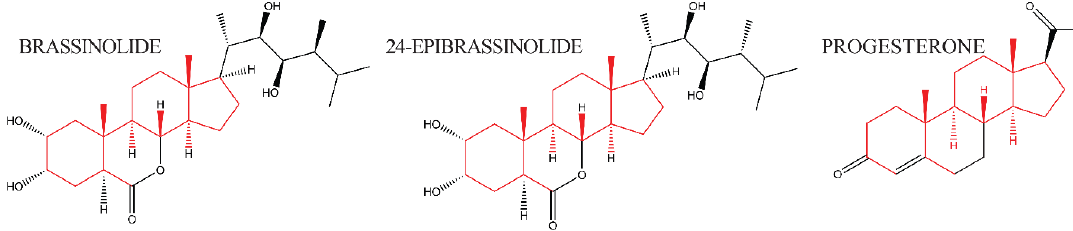
Figure 2. The structure of brassinolide and 24-epibrassinolide, plant steroid hormones related to animal steroid hormone progesterone. Side chains that are structurally conserved are indicated in red; side chains that differ between the hormones are in black.